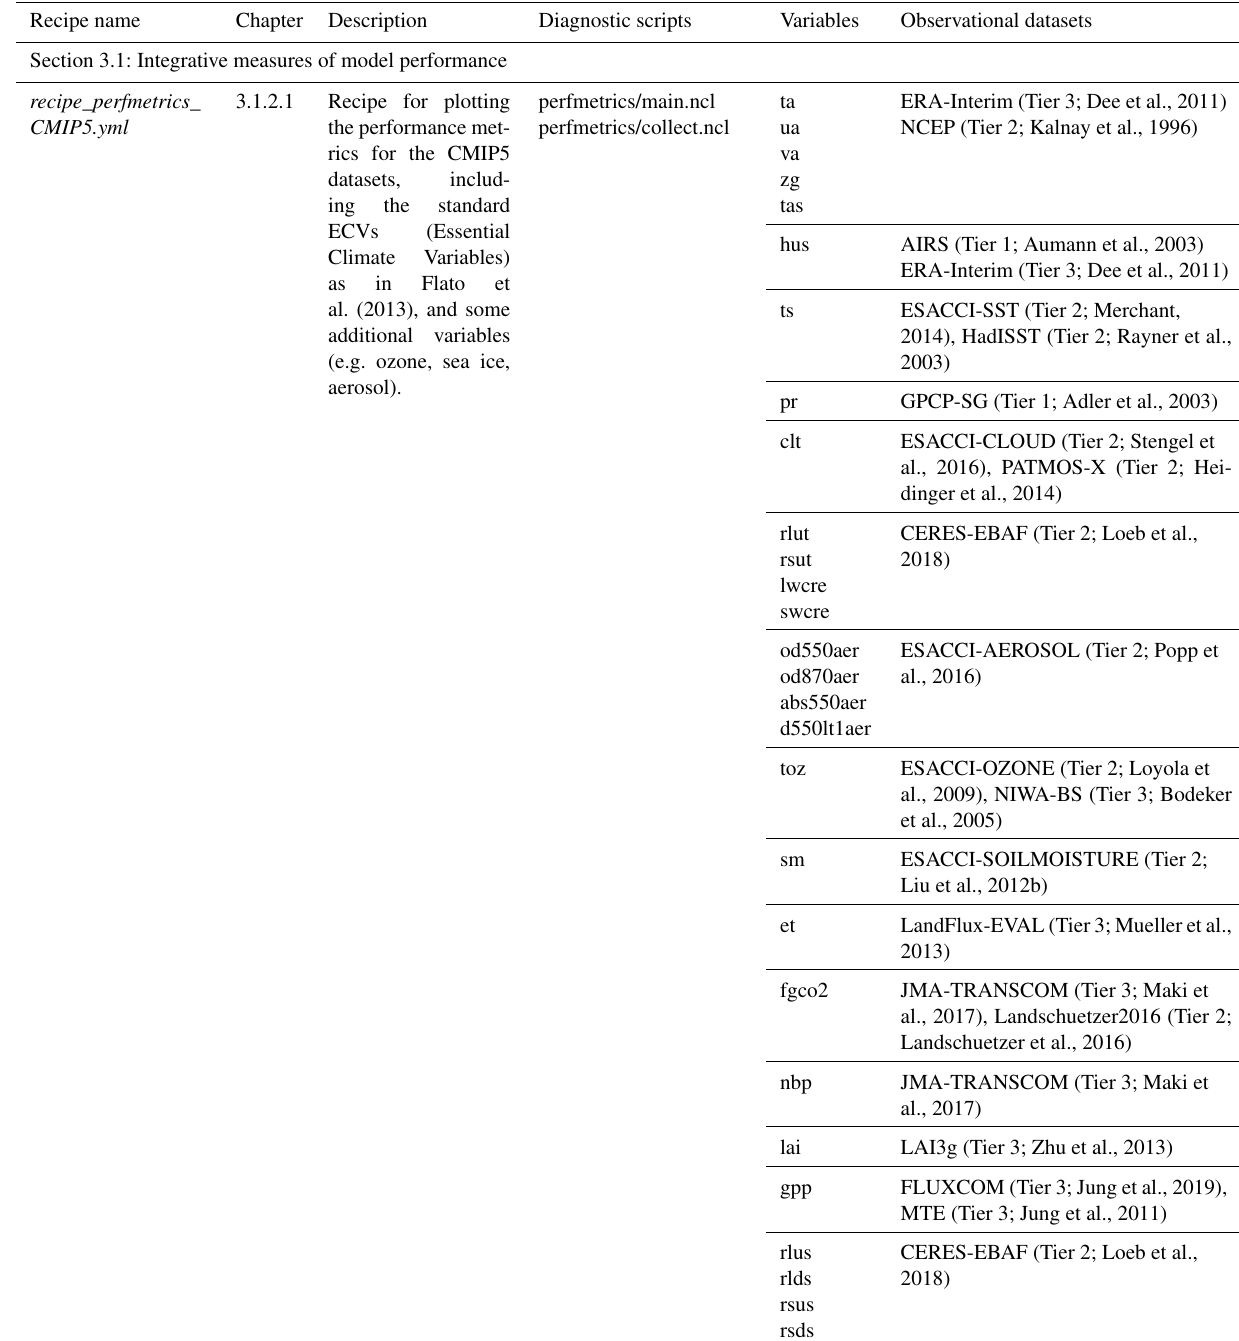
Table 1. Overview of standard recipes implemented in ESMValTool v2.0 along with the section they are described, a brief description, the diagnostic scripts included, as well as the variables and observational datasets used. For further details we refer to the GitHub